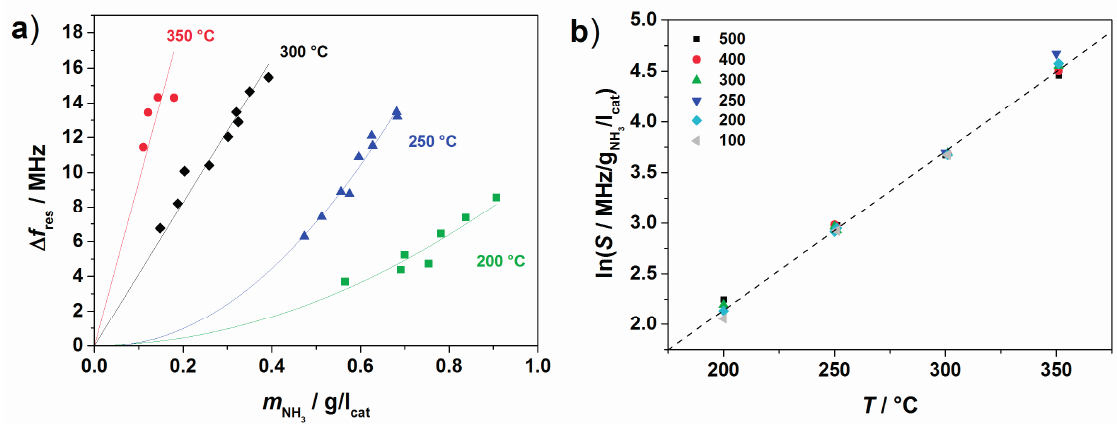
Figure 14. Cu-SSZ-13 honeycomb catalyst: ( a ) resonance frequency shift over stored amount of NH 3 for different feed gas concentrations; ( b ) logarithm of the sensitivity of the high-frequency-based method over temperature for different feed gas concentrations of NH 3 (in ppm). Adapted from [31], with permission from SAE.